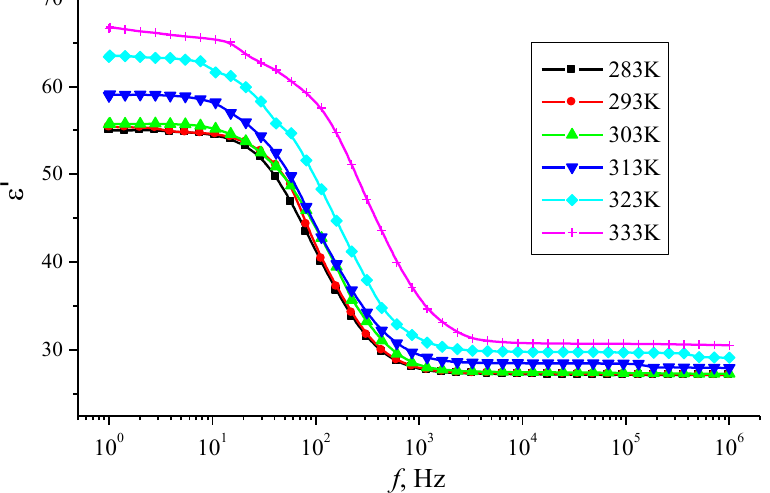
Figure 2. Frequency dependence of the dielectric constant ε (cid:48) of por-Si layers at different Figure 2 . Frequency dependence of the dielectric constant ε ′ of por-Si layers at different temperatures.